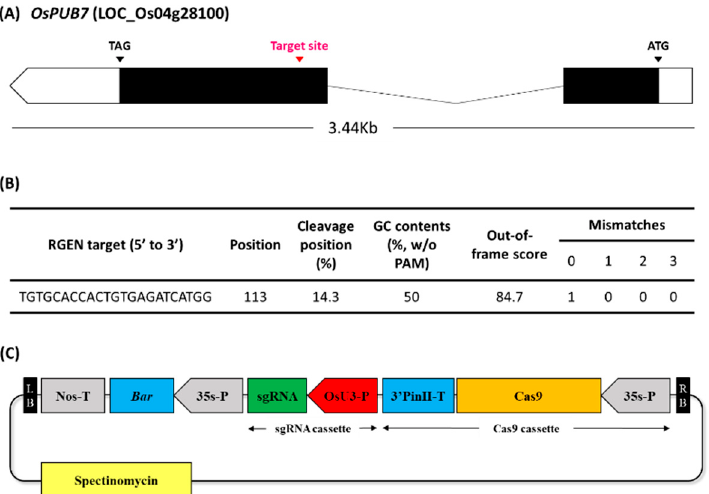
Figure 2. Designing of sgRNA based on CRISPR RGEN Tool (http://www.rgenome.net/ accessed on 2 September 2020). ( A ) Selection of the target region of OsPUB7 using the CRISPR RGEN tool. ( B ) The position of the sgRNA target sites in the OsPUB7 sequence. ( C ) Construction of the Ti-plasmid vector of the sgRNA region for CRISPR/Cas9-mediated mutagenesis of OsPUB7 in rice. LB, left border; RB, right border; Nos, nopaline synthase terminator; Bar, basta resistance gene; sgRNA, single guide RNA; OsU3 -P, Oryza sativa U3 promoter driven sgRNA cassette; Cas9, human codon-optimized Cas9 expressing cassette.